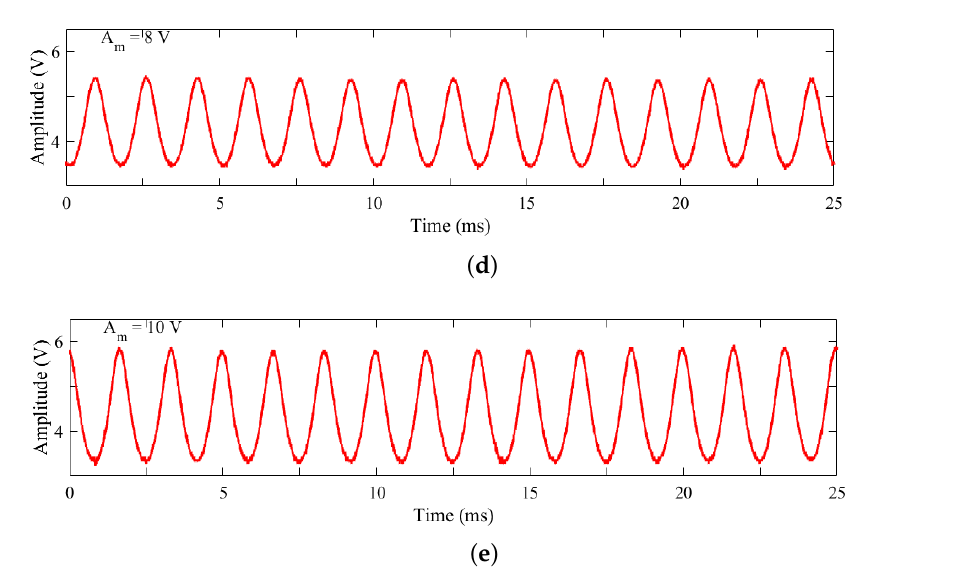
Figure 2. Pump laser diode emission by varying the harmonic modulation amplitude for a fixed frequency f m = 60 kHz and modulation amplitude A m : ( a ) 2 V, ( b ) 4 V, ( c ) 6 V, ( d ) 8 V, ( e ) 10 V.